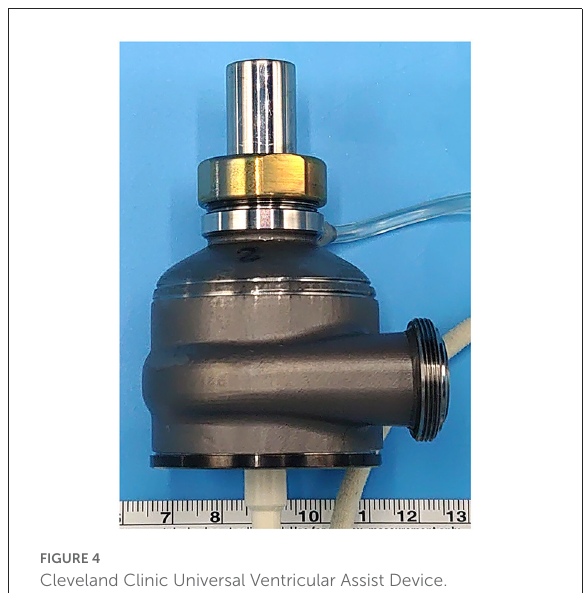
FIGURE4 Cleveland Clinic Universal Ventricular Assist Device.